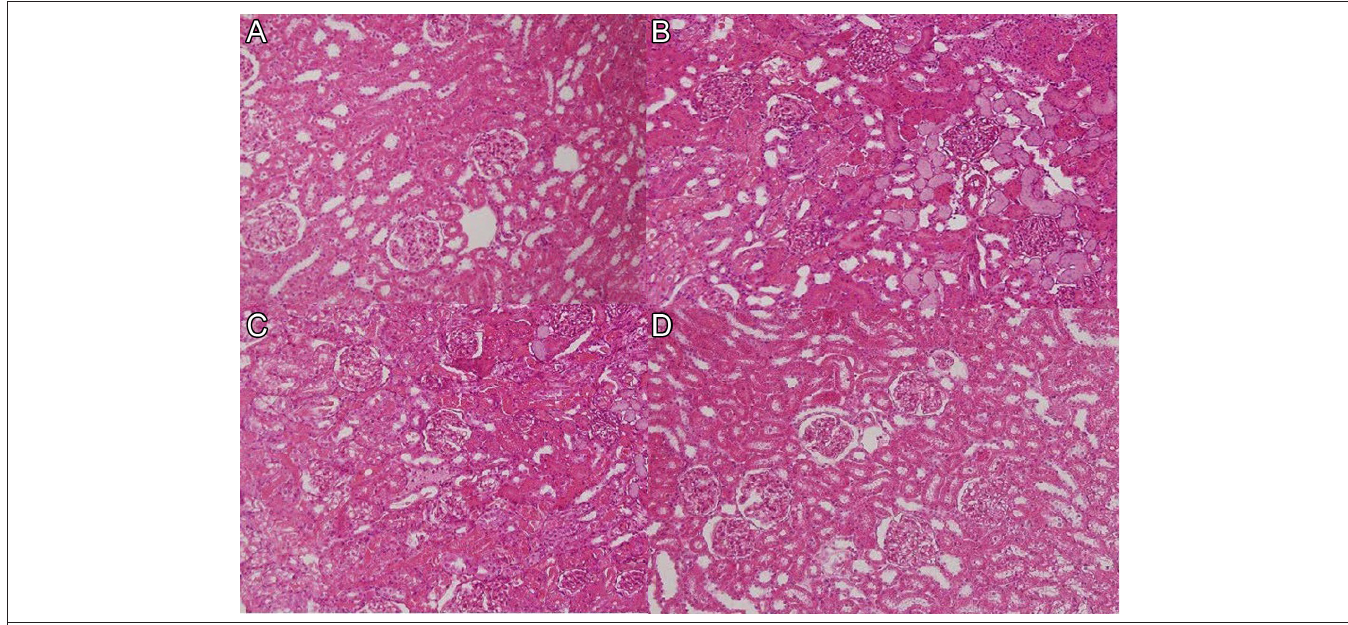
Figure 2. (a). The SP group: Normal corticotubular structure. H&E, × 200. (b). AK group: Kidney sections showing tubular granulovacuolar degeneration and necrosis. H&E, × 200. (c). AK+HPE group: Grade 3 tubular granulovacuolar degeneration and necrosis. H&E, × 200. (d). The HPE group: Minimal focal tubular granulovacuolar epithelial degeneration. H&E, × 200. SP, serum physiologic; AK, amikacin; HPE, H. perforatum